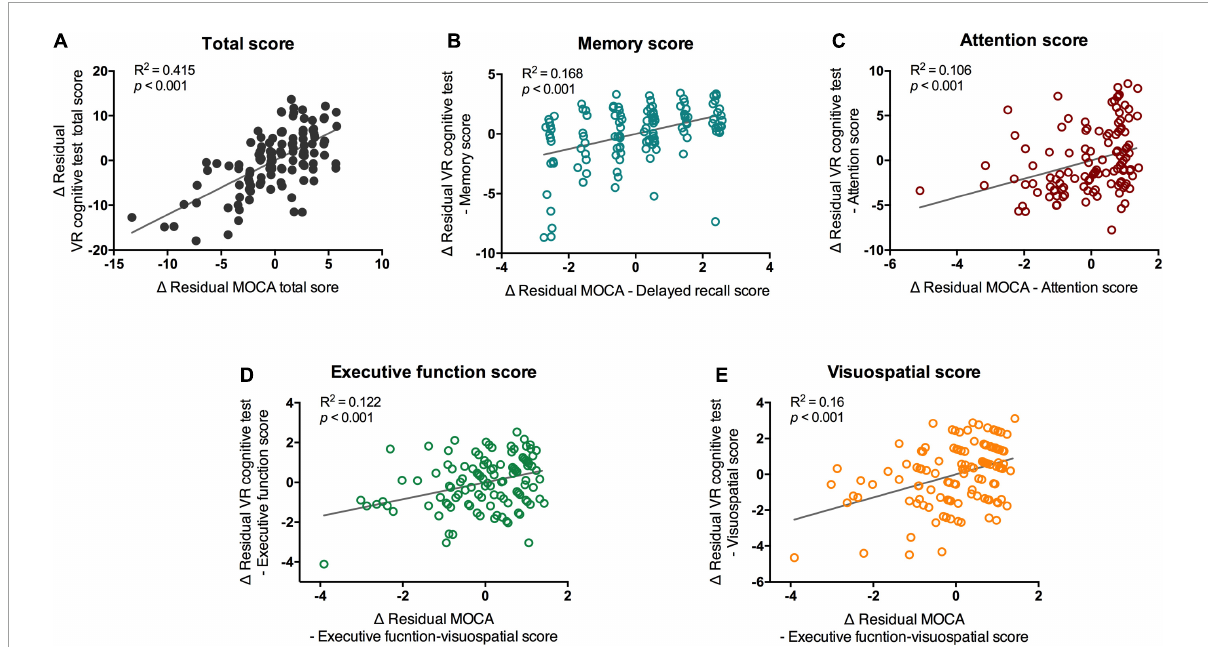
FIGURE3 Partial correlation of scores of VR cognitive test and MOCA test. VR, virtual reality; MOCA-K, Montreal Cognitive Assessment-Korean version. Correlation between VR scores and MOCA scores. Correlation between (A) total scores, (B) memory scores (C) attention scores, (D) executive functions, and (E) visuospatial scores of MOCA and VR test were analyzed with partial correlation test. Line and R 2 value indicate regression of the dataset.